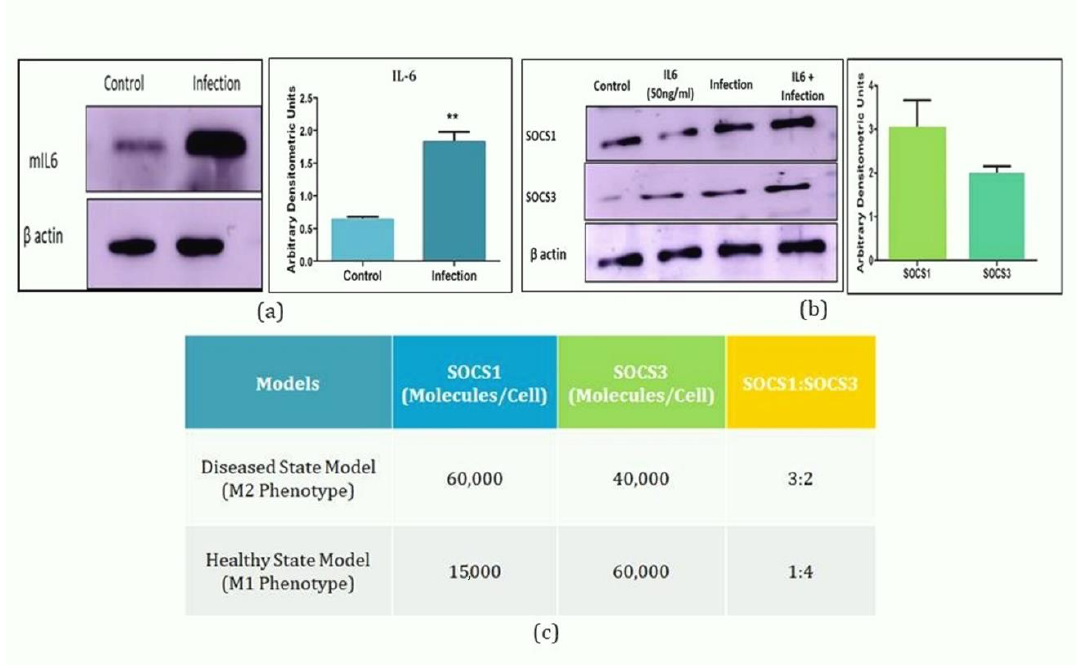
Figure 2. In vitro validation of mathematical model: ( a ) Quantification of IL6 post one hour of infection. ( b ) Quantification of SOCS1/SOCS3 concentration ratio obtained after simulation of mathematical model.( c ) In silico quantification of SOCS1/SOCS3 ratio. Macrophages were exposed to stationary phase promastigotes in ratio of 1: 10 (macrophage: parasite) for 24 hrs and un-internalized parasite was washed followed by treatment of IL6 (50 ng/mL) for 1 h post infection. Ratio was further quantified through western blotting followed by Densitometric analysis of the blots against b actin level. The experiments were performed thrice. Results from one representative experiment are shown. The densitometric value represents mean ± SD with p value ** p < 0.01.